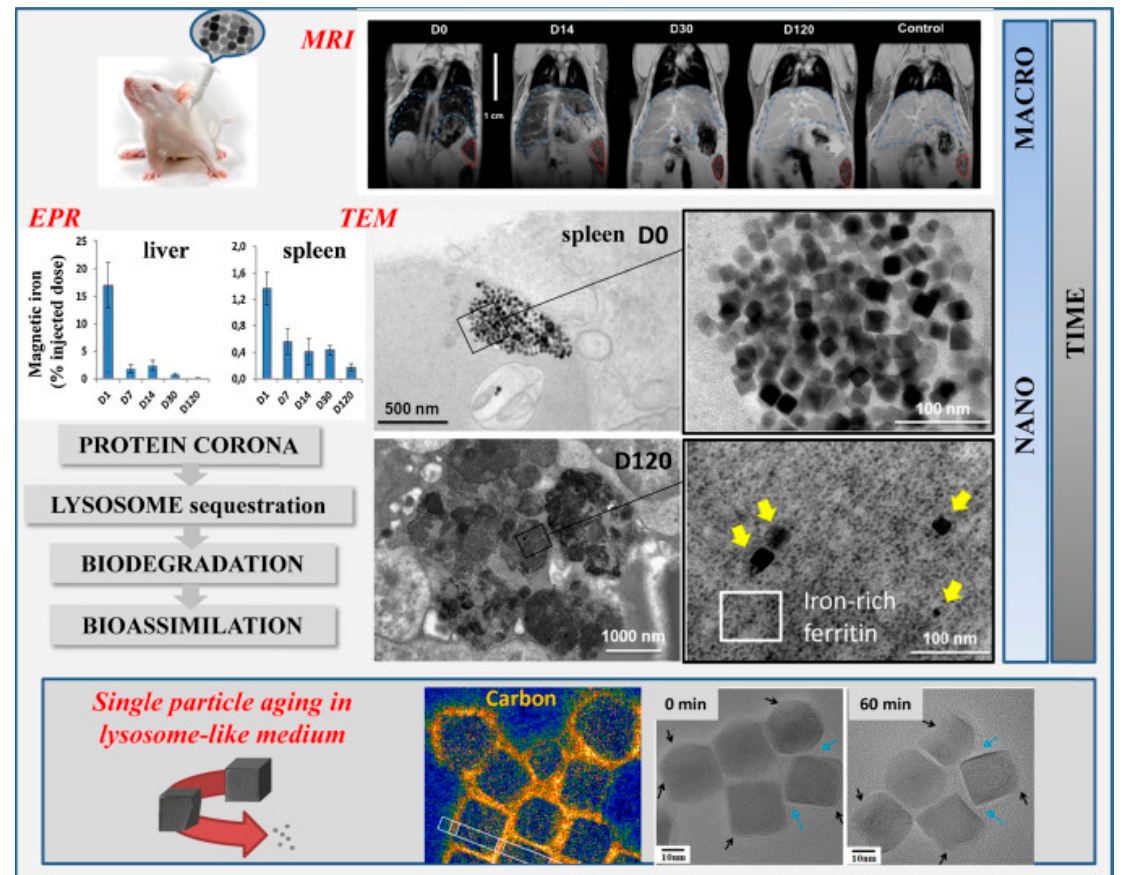
Figure 2. Multiscale follow-up of iron oxide nanocubes over time using in vivo magnetic resonance imaging (MRI) in mice, ex vivo electron paramagnetic resonance (EPR) quantification in organs, TEM observations of intracellular distribution and morphological biotransformations (reproduced with permission from [104] .